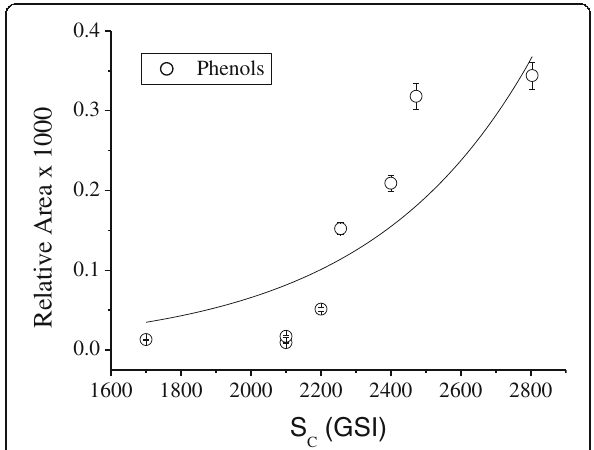
Fig. 14 Relation between Sc and the relative area under the TD-GC/ MS chromatographic signal for phenols and fatty acids